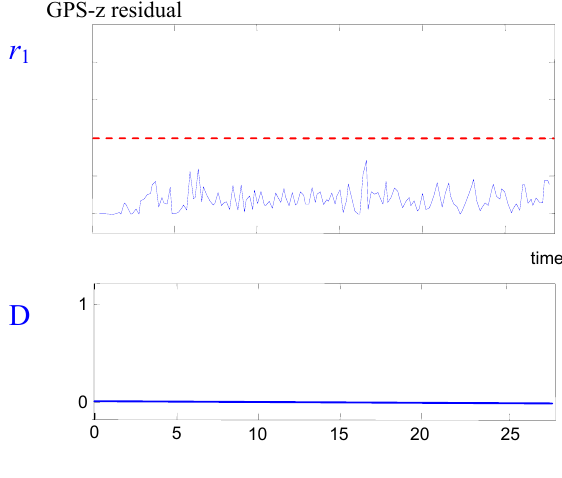
Figure 3. Slow-growing drift GPS-z sensor failure detection. Upper plot: residual signal r Lower plot: fault detection